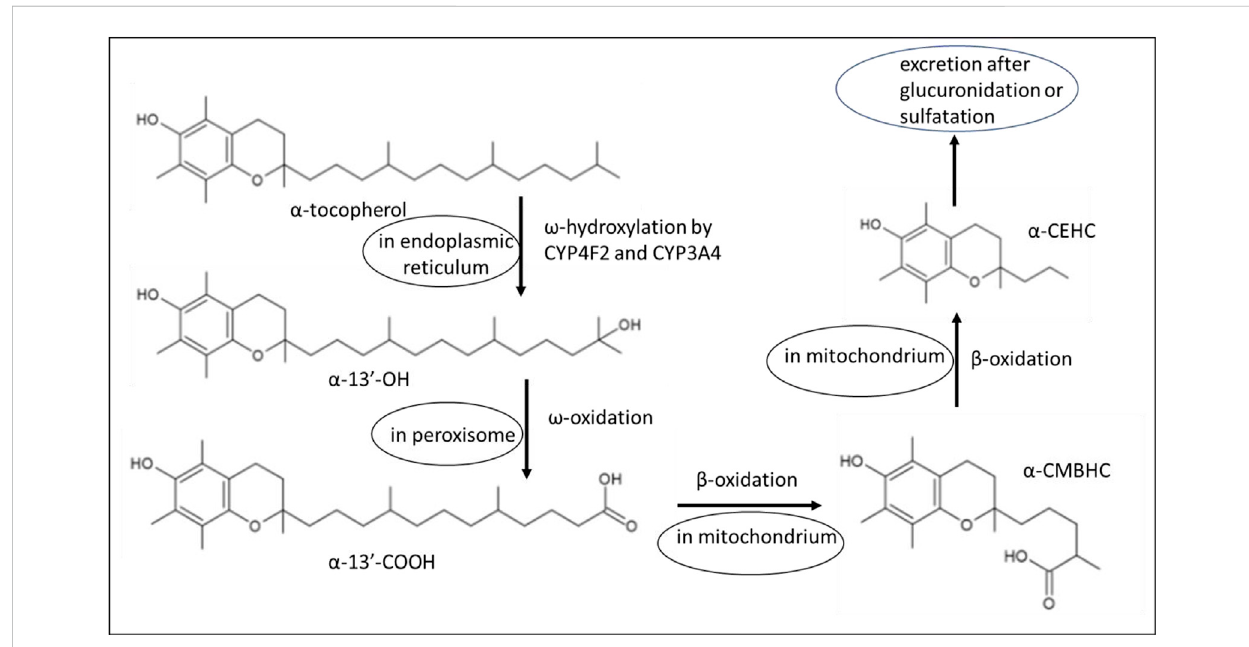
A detailed scheme with chemical structures of α -tocopherol metabolites in various cellular departments. Explanation of thechemical structures: α - 13 ′ -OH, 13 ′ -hydroxychromanol; α -13 ′ -COOH, 13 ′ -carboxychromanol; α -CEHC, carboxymethyl butyl hydroxy chromanol; α -CMBHC, carboxymethyl hexyl hydroxy chromanol.